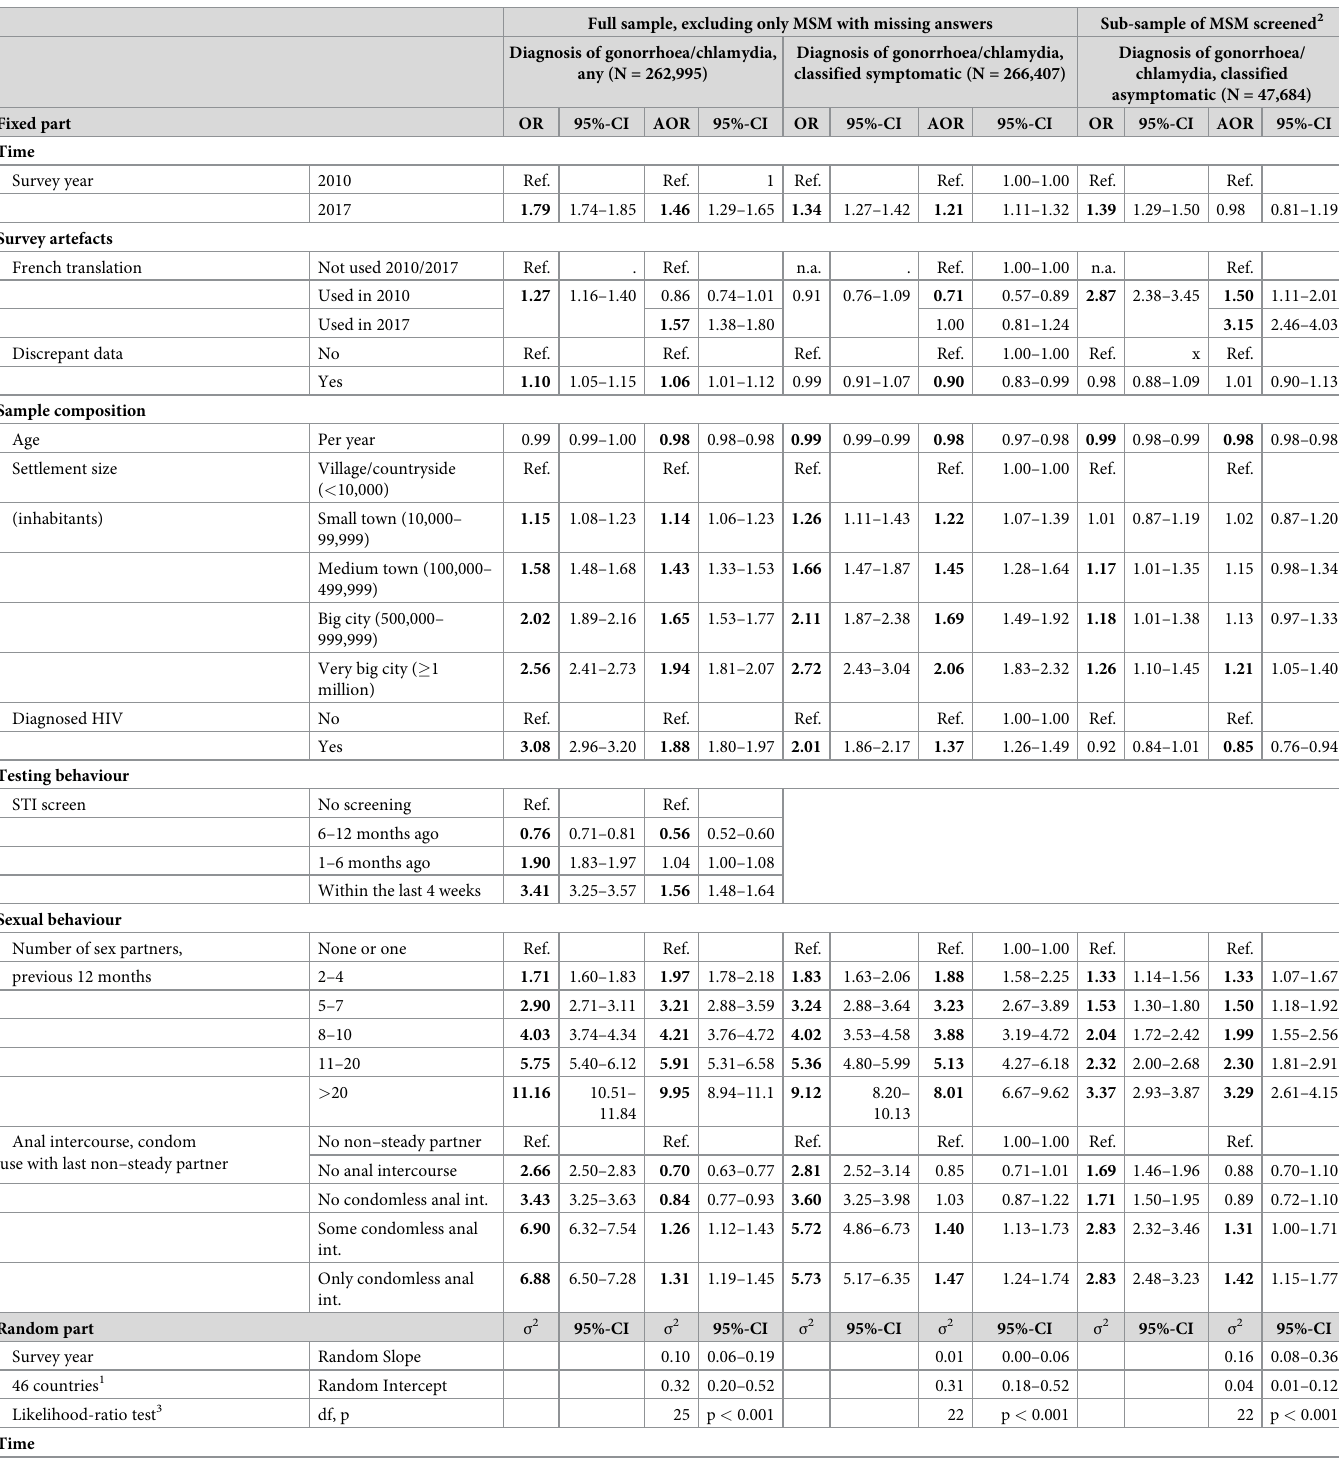
Table 2. a. Univariable and multivariable regression analysis, main model: individual-level associations with gonorrhoea/chlamydia diagnosis. b. Univariable and multivariable regression analysis, main model: individual-level associations with gonorrhoea/chlamydia diagnosis including impact of country-level 1 screening rates on gonorrhoea/chlamydia diagnosis (intervention